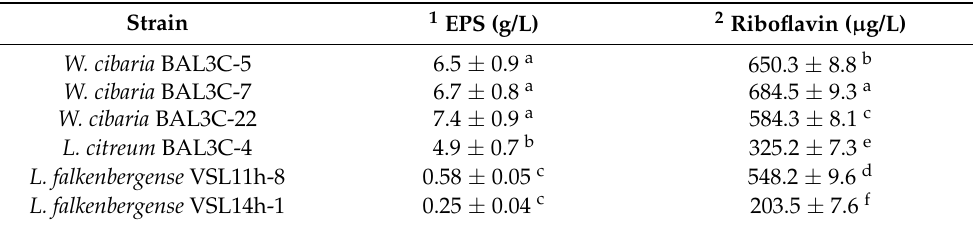
Table 2. Exopolysaccharide (EPS) and riboflavin production by lactic acid bacteria grown in RAM medium supplemented with 2%